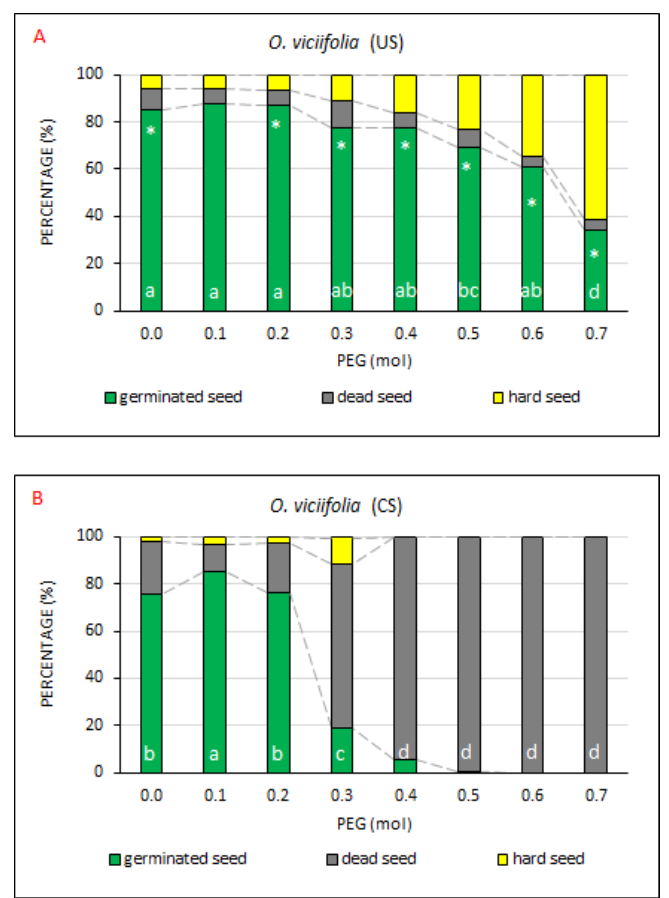
Figure 10. The comparison of germinated, dead and hard seed percentages at drought simulation degrees. Average percentages of GS, DS and HS for O. viciifolia , the ( A ) US (uncoated seeds; n = 4 ± SE) and ( B ) CS (coated seeds; n = 4 ± SE) treatments at the respective PEG concentrations = 0.0 – 0.7 mol. Different lowercase letters indicate a significant difference (ANOVA post-hoc Tukey´s HSD test; p < 0.05) between the percentages of GS values in the US and CS treatments. The * symbol represents a significant difference in the percentages of GS values between US and CS at a specific PEG concentration.